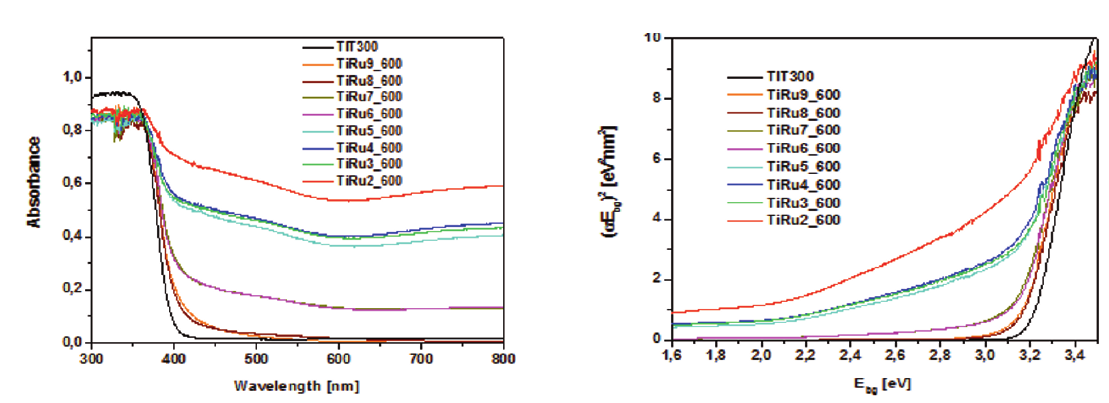
Figure 7. Absorbance UV/VIS spectra of prepared Ru-doped titania samples and undoped titania (TIT 300).